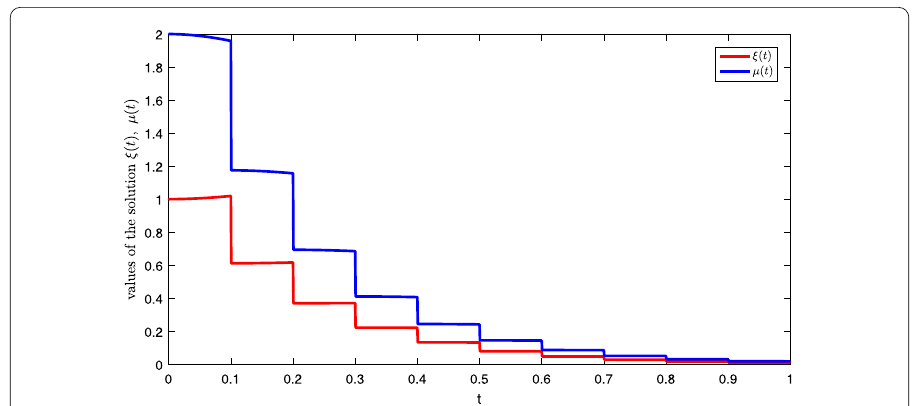
Figure 1 Graphical representation of HU-stability results for Example